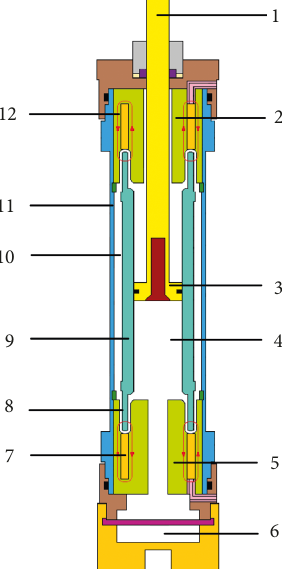
Figure 13: Schematic views of MRF damper with bifold config- uration of electromagnet. 1, piston rod; 2, magnetic structure as- sembly; 3, piston; 4, inner chamber; 5, magnetic end structure assembly; 6, pneumatic chamber; 7, electrical coil; 8, cavity; 9, inner tube; 10, outer chamber; 11, outer tube; 12, flux return